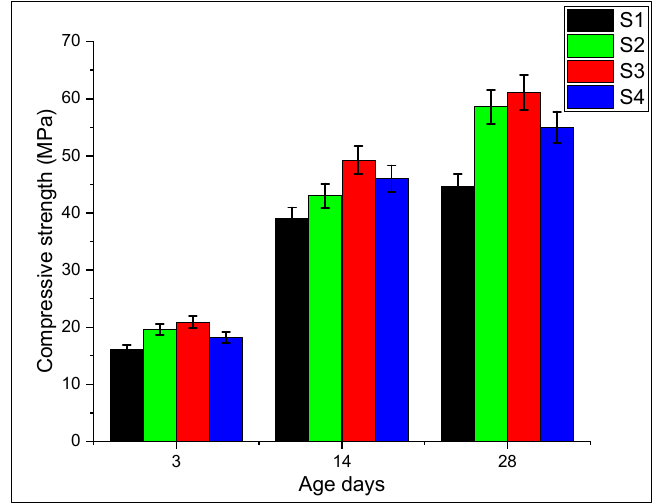
Figure 19. Strength of nanocomposite modified Figure 19: Strength of nanocomposite modified mortar